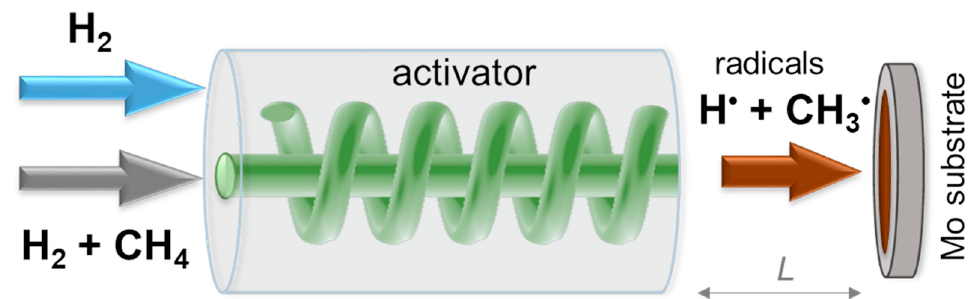
Figure 1. Scheme of the synthesis process of diamond films using the thermally activated gas-jet method. Table 1. Heating power (P), flow rate of hydrogen (R H ) and methane (R m ), substrate temperature (T s ), presence of diamond seeds, and synthesis duration for Samples 1–3.